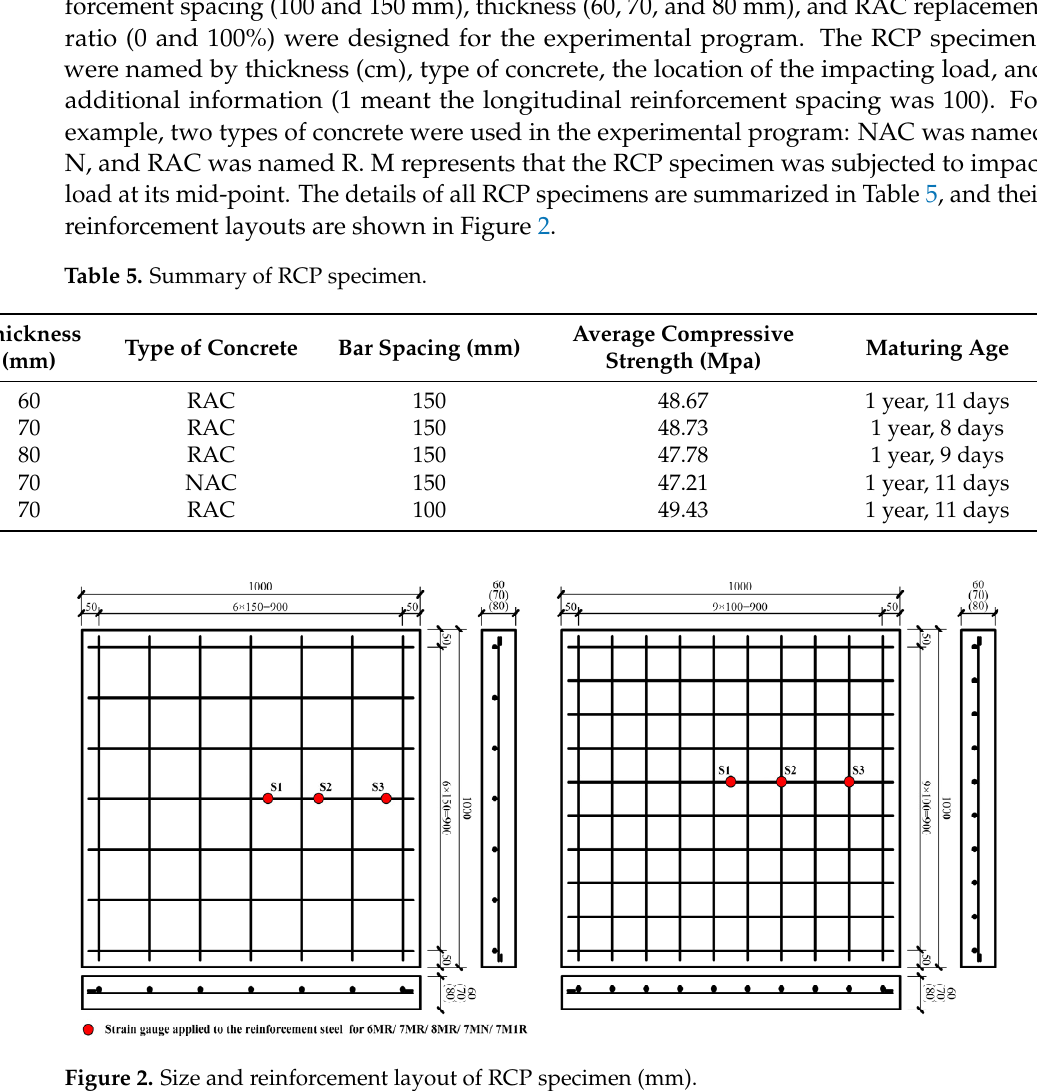
Table 4. Mechanical properties of concrete.